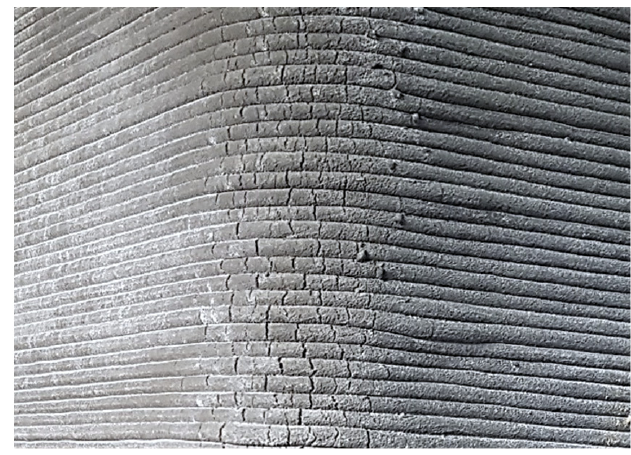
Figure 3. Development of cracks at the corner of a fresh-printed concrete wall.